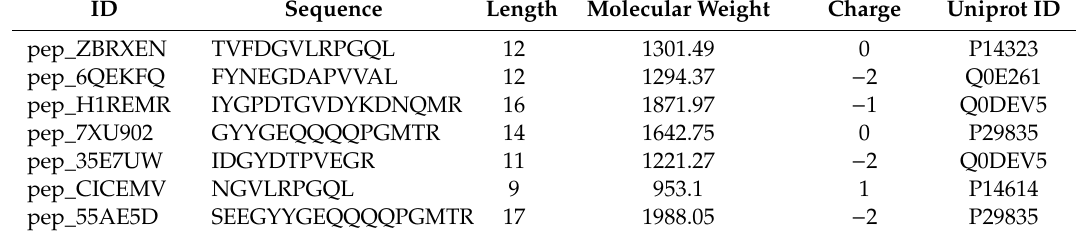
Table 1. Sequence and parent protein information for seven positively predicted peptides in rice NPN.